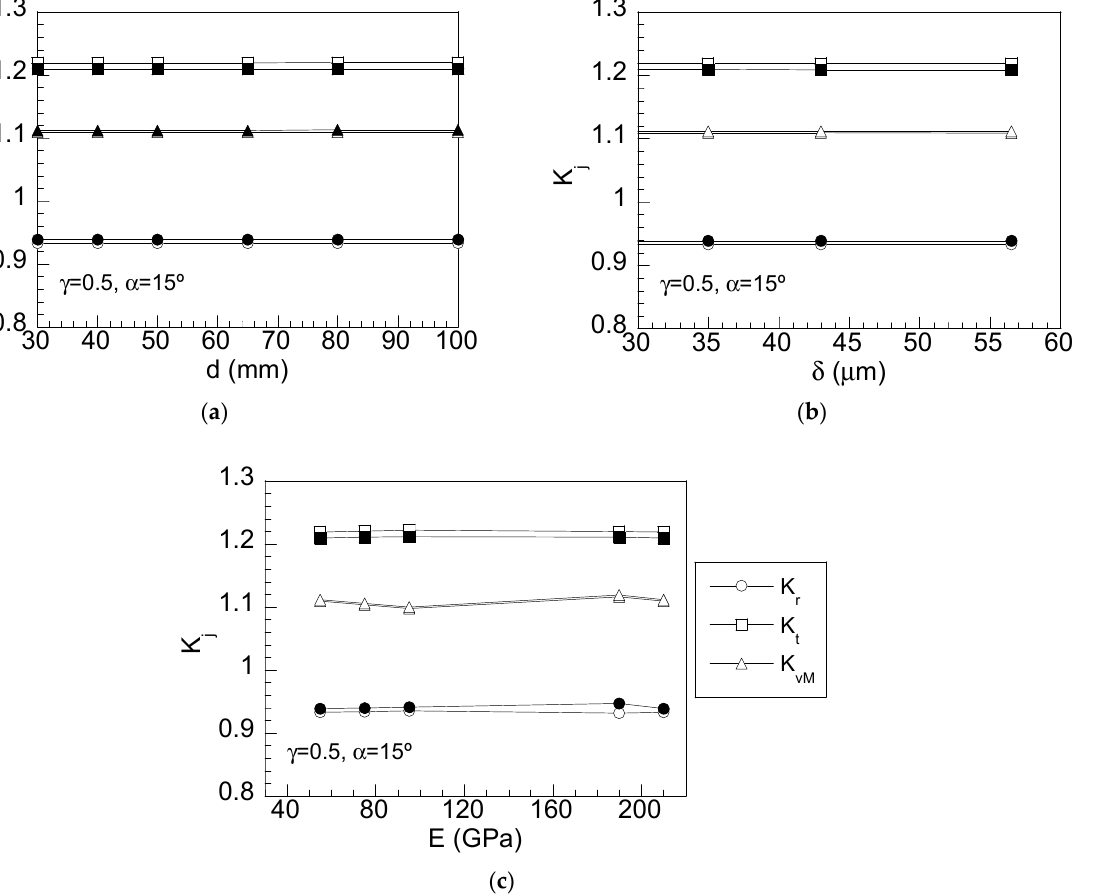
Figure 14. Variation of the radial, tangential, and von Mises SCFs for full–chamfer (blank symbols) and partial–chamfer hubs (full symbols) with ( a ) diverse shaft dimensions, ( b ) different interference fits, and ( c ) diverse materials.